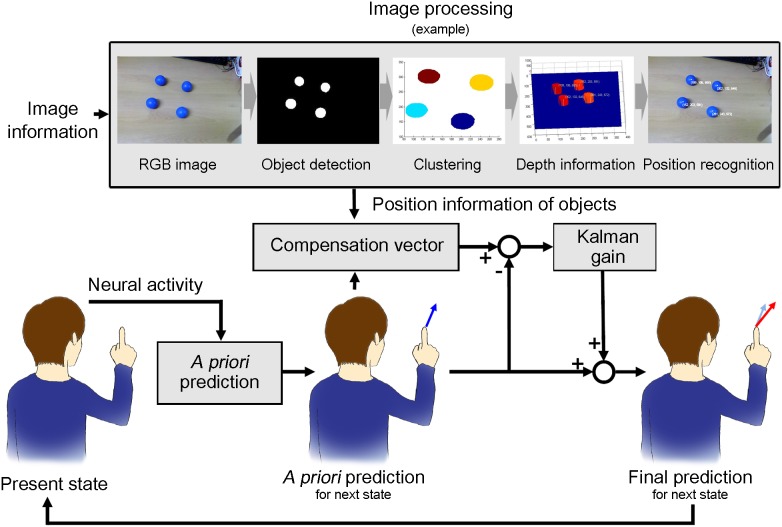
A BMI framework combining image processing.The BMI framework receives image information through external device. Position information of objects are calculated from the image information by image processing. The proposed FPA algorithm generates a compensation vector based on the position information and A priori prediction. The purpose of the compensation vector is to rotate the prediction vector toward the predicted target and magnify the predicted vector to easily reach the target. The FPA predicts the movement and compensates using the position information recursively.